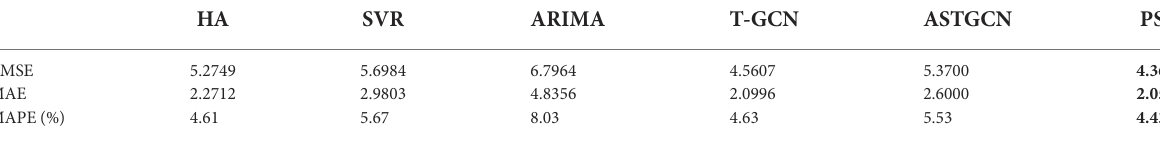
TABLE 2 PEMS04-60 min.